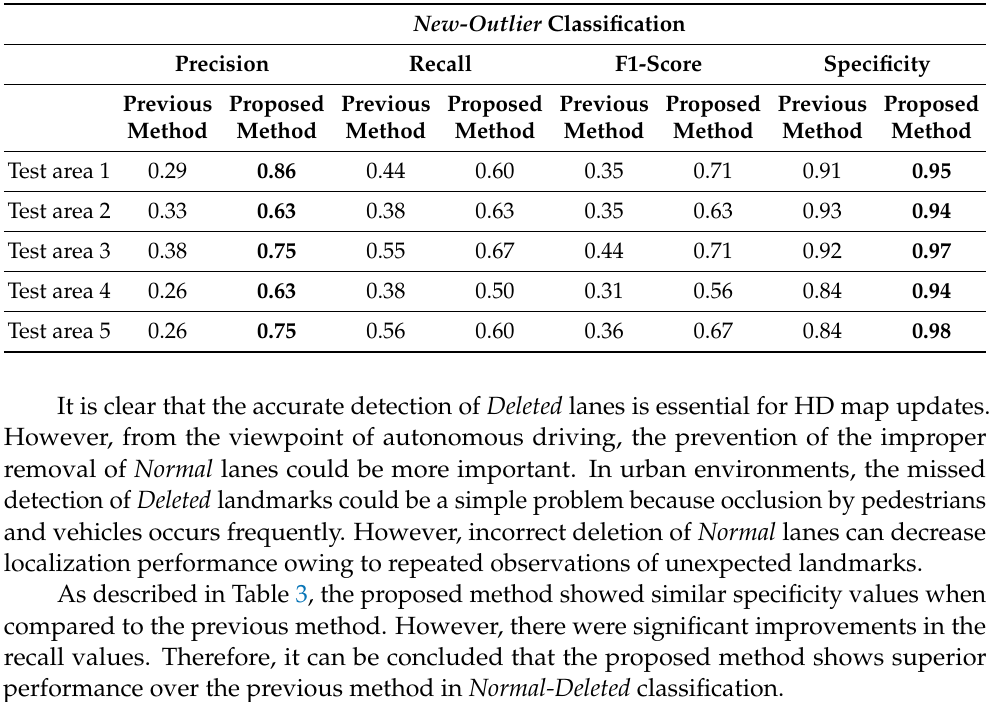
Table 4. Quantitative evaluation results for the New-Outlier classification for the previous and proposed